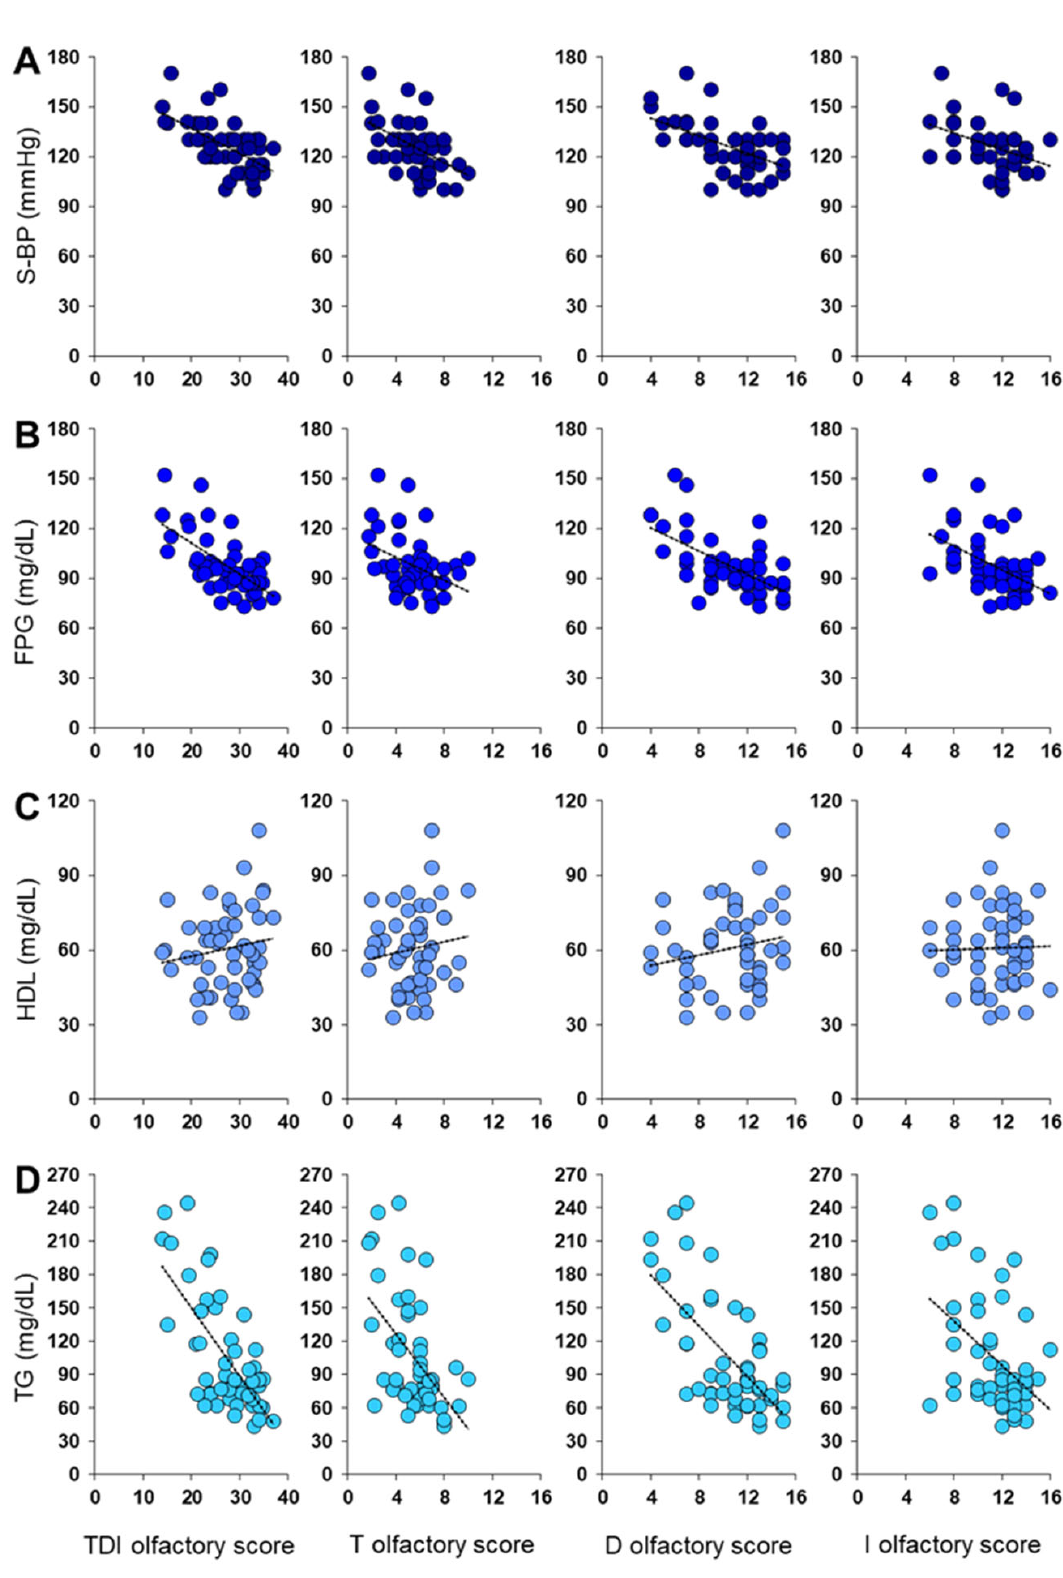
Figure 3. Correlation analysis between olfactory scores obtained by each female patient and her ( A ) Systolic Blood Pressure (S-BP), ( B ) Fasting Plasma Glucose (FPG), ( C ) HDL levels, and ( D ) triglycerides levels (TG).